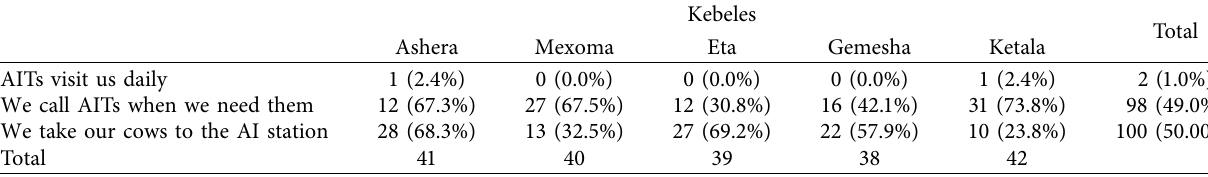
Table 8: Te results of means of communication used to report cows for AI service.